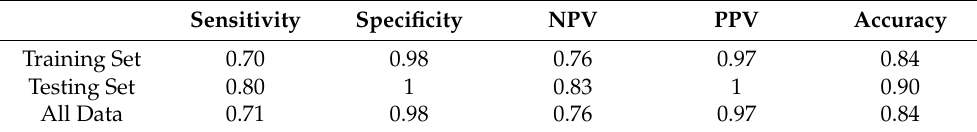
Table 1. Performance metrics of the model for the detection task in the training set and testing set.